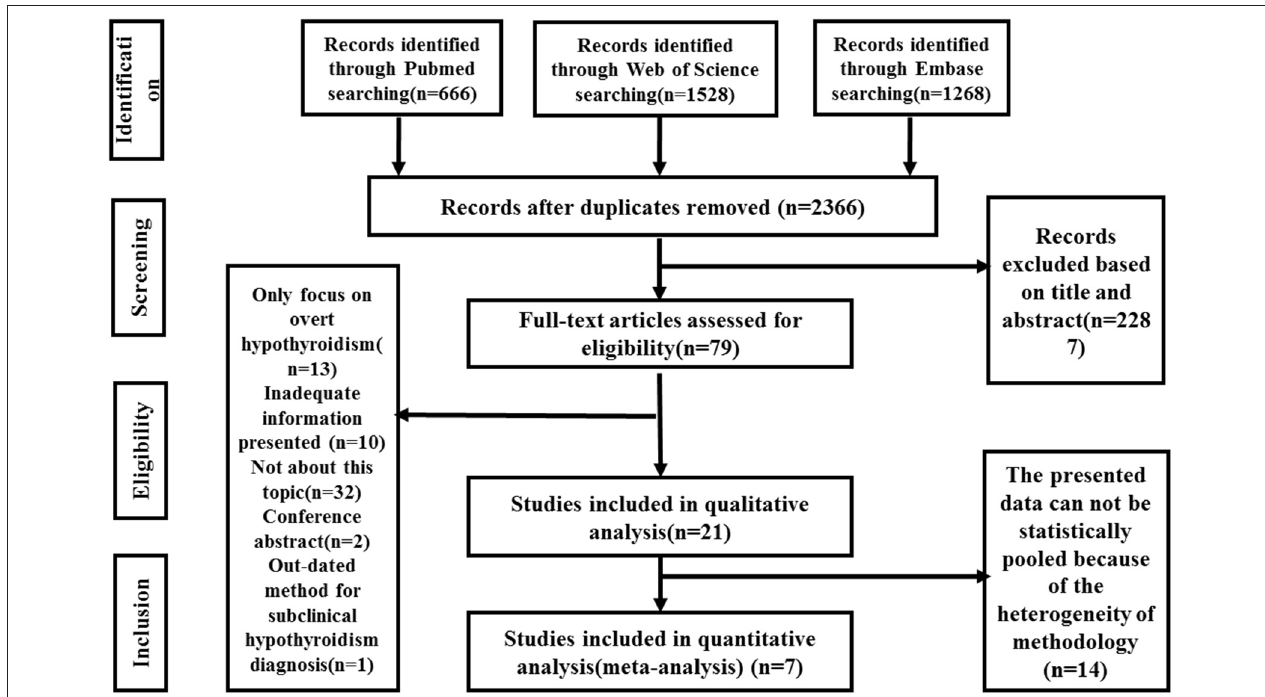
FIGURE 1 | Meta-analysis flow chart. RCT, randomized controlled trial; L-T4, levothyroxine; SCH, subclinical